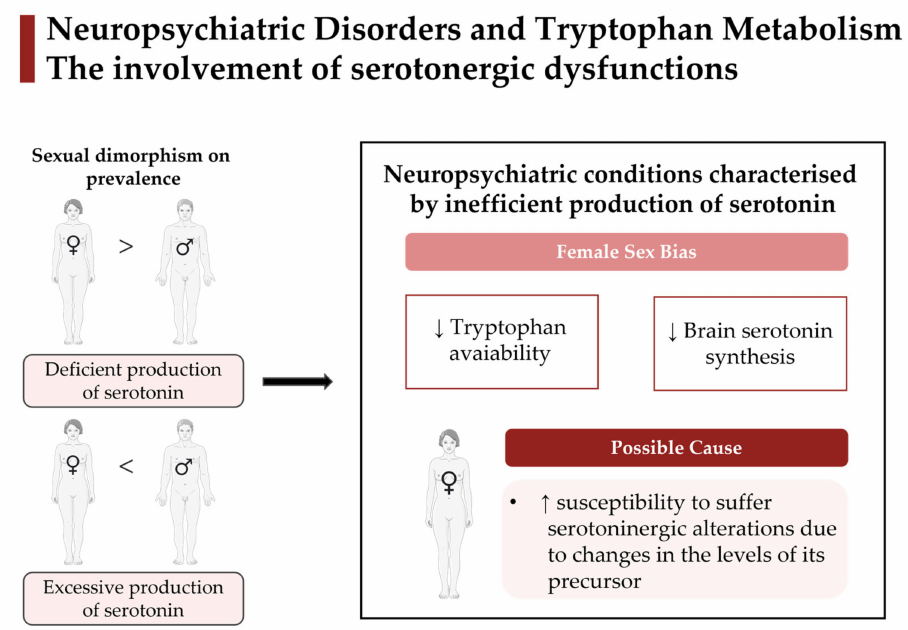
Figure 3. Sexual bias for some neuropsychiatric conditions seems to be related to opposite dis- turbances in the (5-HT) system. On one hand, most neuropsychiatric disorders with aggravated manifestations in women (e.g., depression, affective, and mood disorders) are associated with defi- cient production of serotonin. On the other hand, some conditions that affect more males than females (e.g., ASD and ADHD) have excessive production of that neurotransmitter. Specifically, female sex bias in neuropsychiatric diseases appears to be involved in a reduced availability of this amino acid pool and 5-HT synthesis. Further, women have higher susceptibility than men to suffer serotoninergic alterations due to changes in the levels of its precursor Tryp. These changes in Tryp metabolism and, consequently, in the serotoninergic system can lead to sexual dimorphisms on the prevalence and severity of neuropsychiatric disorders. The Figure was partly generated using Servier Medical Art, provided by Servier, licensed under a Creative Commons Attribution 3.0 unported